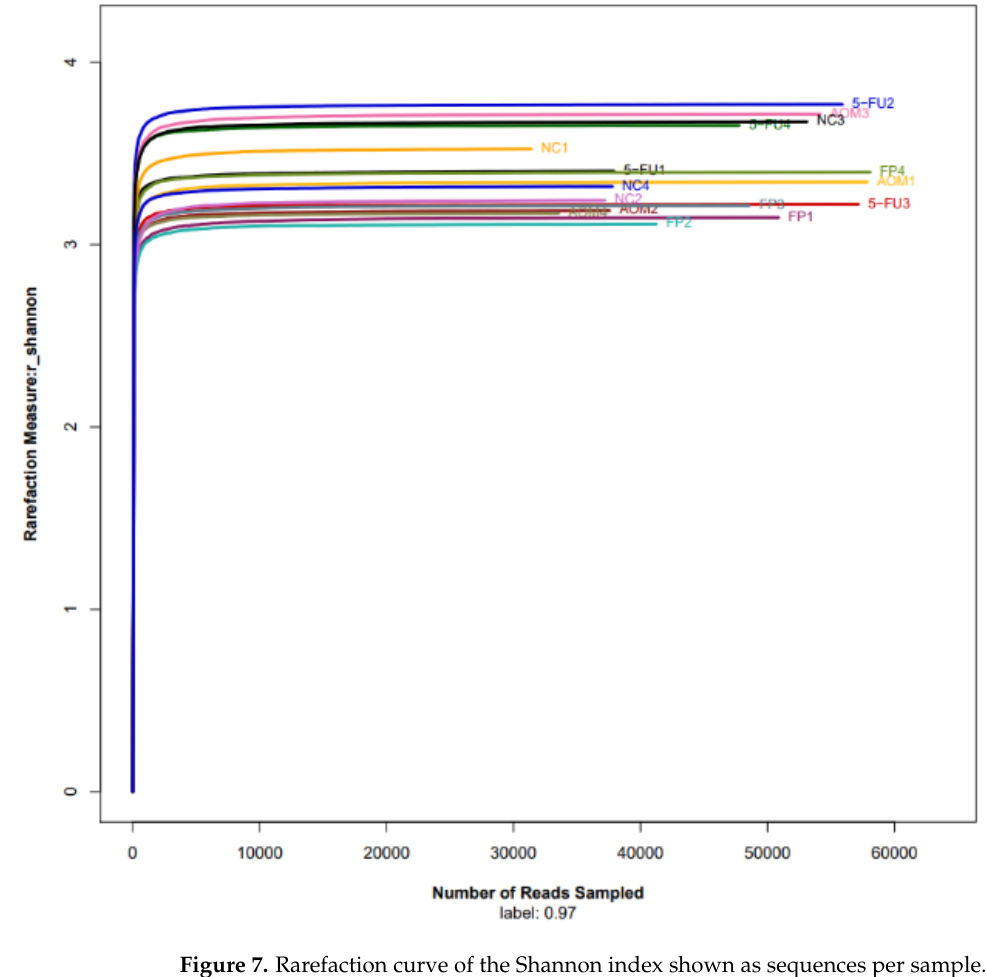
Figure 7. Rarefaction curve of the Shannon index shown as sequences per sample. The x-axis shows the number of reads per sample, while the y-axis indicates the Shannon index. Each curve represents a different sample and is illustrated in a different color. A lower Shannon index indicates higher diversity while higher values indicate less diversity. The microbiota of the control (NC) samples was significantly less diverse than that in the other groups. (NC): Normal control group, (AOM): azoxymethane control group, (FP): F. prausnitzii group, (5FU): 5-fluorouracil reference group.